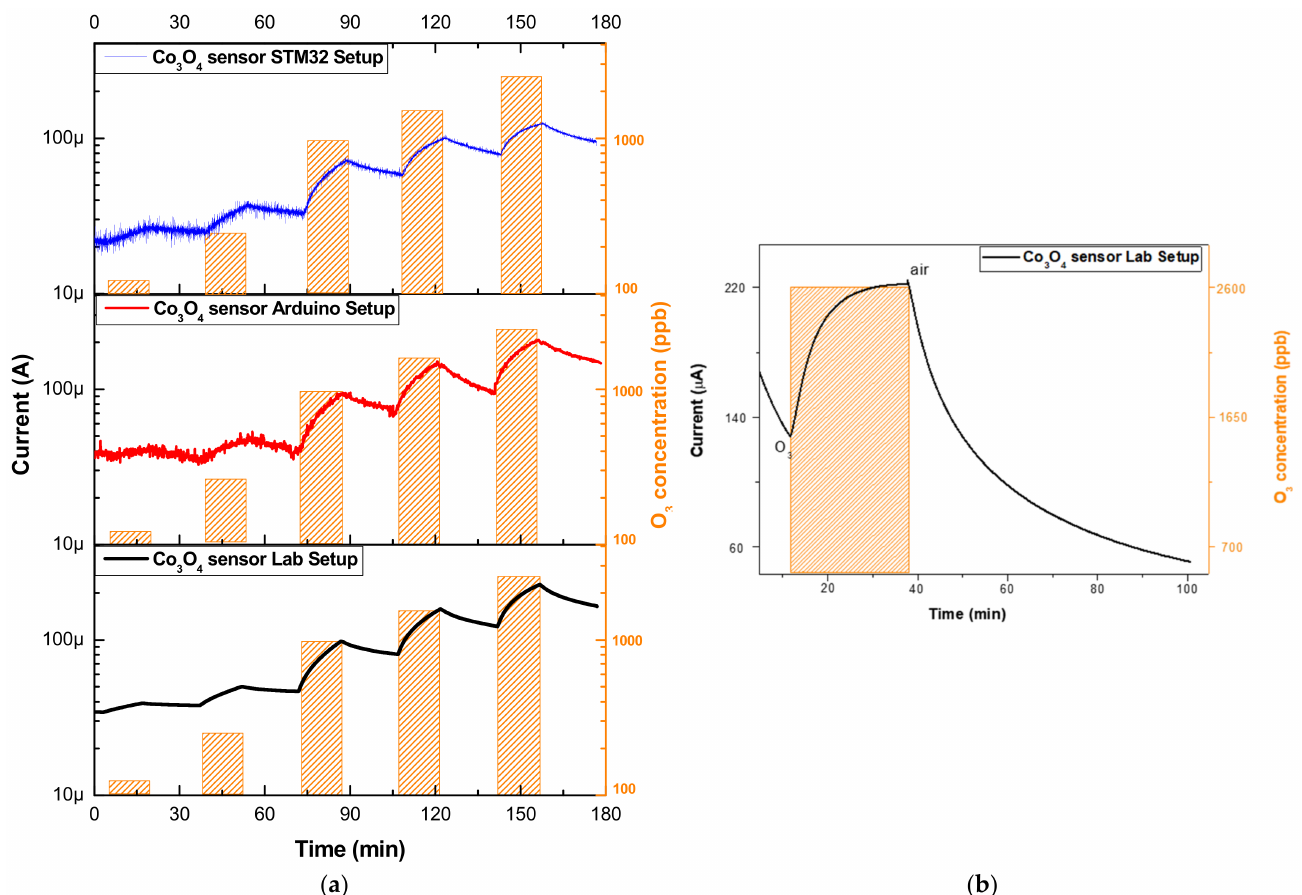
Figure 5. Variation in the electrical current of Co 3 O 4 film measured ( a ) by 3 different setups under exposure to 120–2600 ppb O 3, and ( b ) Lab setup under long exposure to 2600 ppb O 3 at room